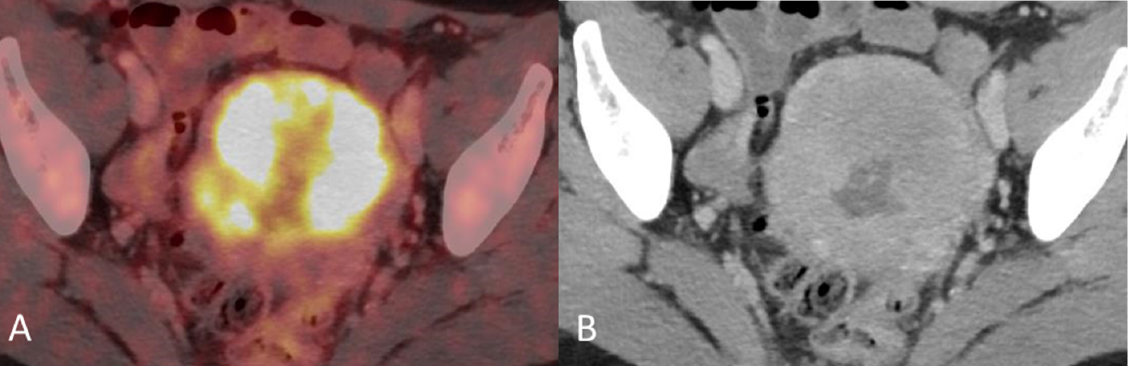
2 of 7 Figure 1. A 57-year-old post-menopausal woman underwent gynecological examination due to in- termittent vaginal bleeding over the course of one month with no other symptoms. On transvaginal ultrasound, a tumor thought to represent a leiomyoma was reported. A subsequent hysteroscopy showed the uterine cavity to be filled with soft necrotic tissue, suspected to derive from a leiomy- oma. However, histological examination depicted hepatoid adenocarcinoma. At the time of diagno- sis, the laboratory work-up for tumor markers showed S-AFP 110610 (ref: <12 kIU/L), Ca-125 13 (ref: < 35 kU/L), CA 19-9 17 (ref: < 37 kU/L) and CEA 4 (ref: <5µg/L). 18 F-FDG PET/CT was performed for